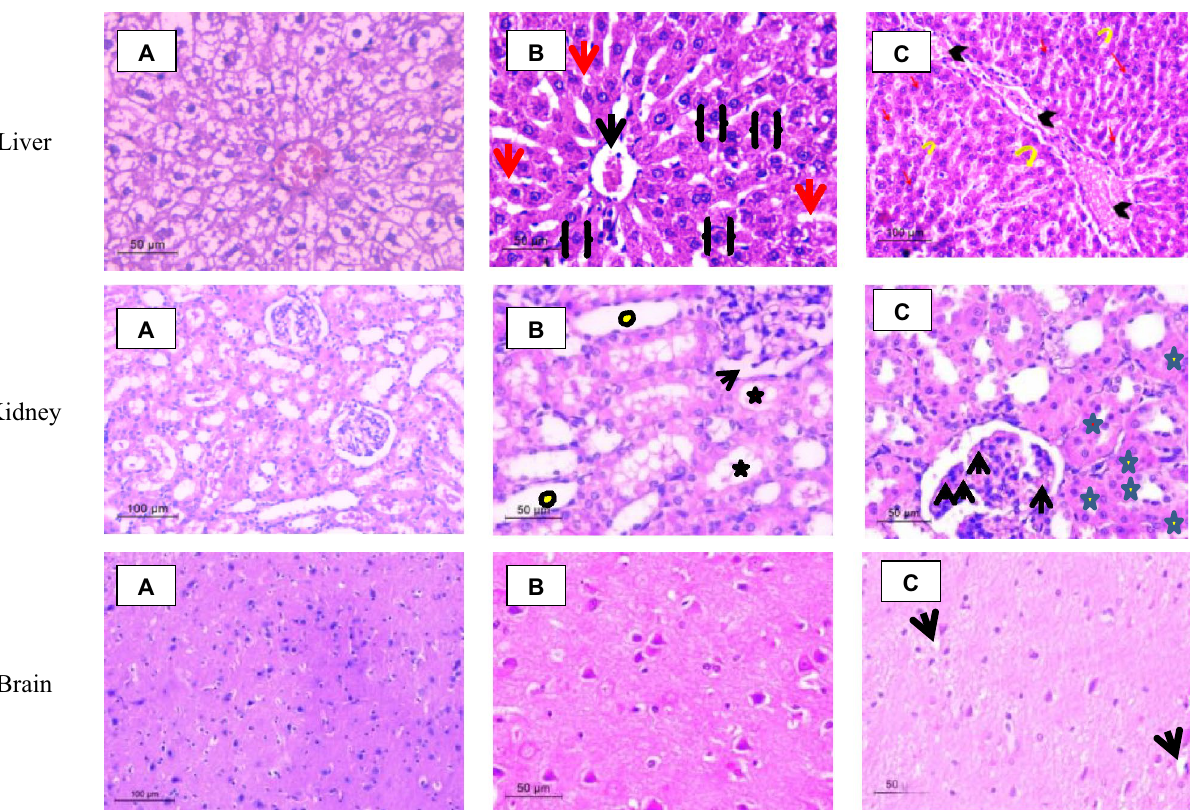
Figure 5. Light micrographs in liver tissue where ( A ) Liver sector of control rat showed normal tightly packed cords of hepatocytes with rounded vesicular nuclei, ( B ) Liver sector of low dose treated group (Group 2) showed hepatocytes radiating from central vein with normal endothelial cells. Dilated congested central vein (black arrow), Dilated blood sinusoids (red arrows) and Ballooned hepatocytes (black brackets) ( C ) Liver sector from high dose treated animals illustrated indefinite cell boundaries which confirm hepatocytes damage; severe congestion in central vein (black head arrow), nuclear changes (red arrows) and blood sinusoids congestion (yellow bent arrows). While, in kidney where ( A ) Light renal micrographs illustrate control rat received normal saline demonstrating normal histological architecture. ( B ) Light renal micrographs of low doses treated rats (Group 2) demonstrating most of convoluted tubules were apparently less or more normal (yellow and black Strikes) and normal architecture of bowman’s capsule with space lining (arrow). ( C ) Light Renal micrographs of high dose treated rats (Group 3) reveling normal architecture of bowman’s capsules with little glomerular congestion or inflamed glomeruli (arrows), normal renal tubules with few number of necrotic ones (yellow star). Lastly, brain cerebral cortex illustrate ( A ) control rat (received normal saline) ( B ) Au-NPs low dose treated (Group 2) demonstrating normal histological architecture. ( C ) Au-NPs high dose treated (Group 3) demonstrating only two narrow vacuoles (black